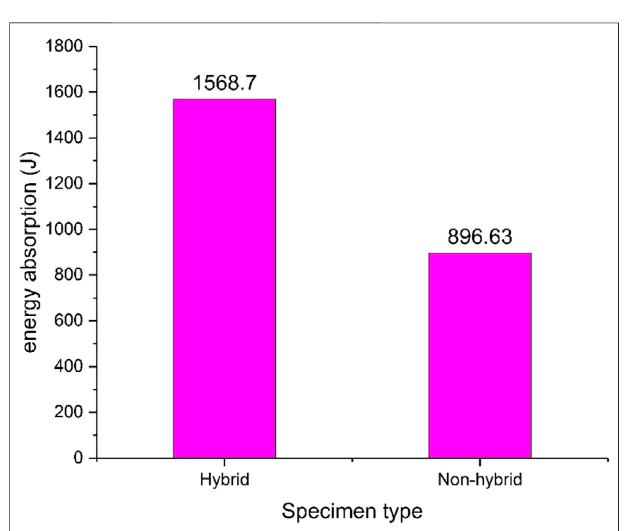
FIGURE 8 | A comparison of energy absorption between nonhybrid and -hybrid composite